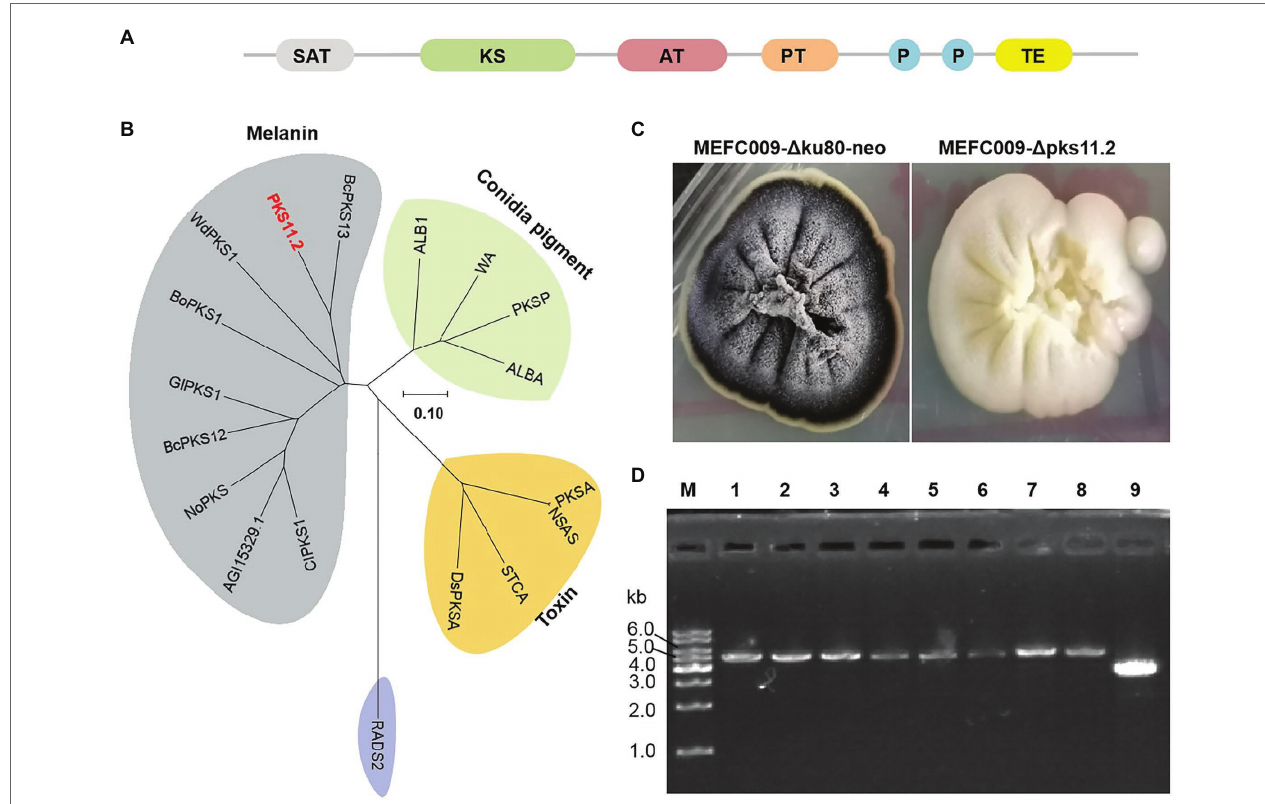
FIGURE 6 | Identification of DHN-melanin PKS in C. empetri MEFC009. (A) Domain structure of PKS11.2. (B) Phylogenetic analysis of PKS11.2. PKS11.2 grouped with the melanin biosynthesis PKSs. The accession numbers of all used PKSs were listed in Supplementary Table S3 . (C) Colonial morphology of C. empetri MEFC009- Δ ku80-neo and C. empetri MEFC009- Δ pks11.2. (D) Genotype verification of transformants using primers Upks11.2-F/Dpks11.2-R. Lane M: 1 kb DNA marker; lane 1–8: C. empetri MEFC009- Δ pks11.2; lane 9: parent strain C. empetri MEFC009- Δ